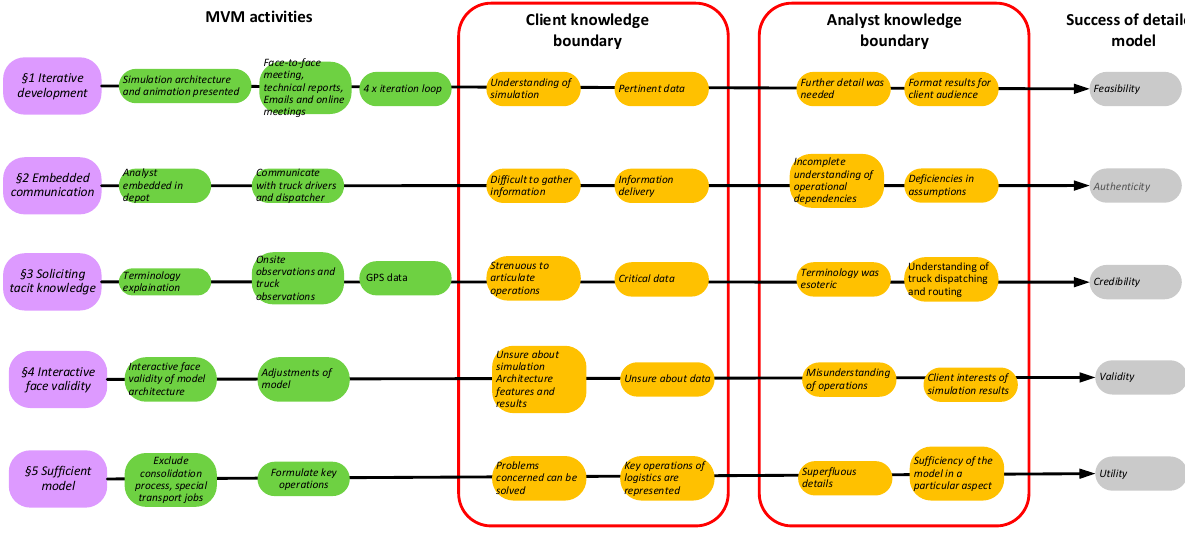
Figure 13. Application of the five MVM principles—a possible pathway to implementation.